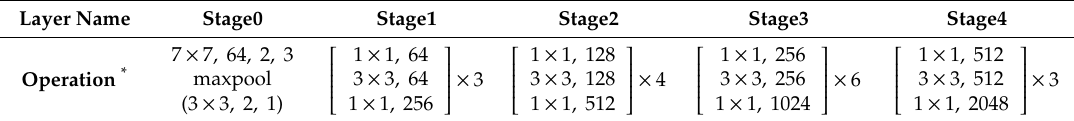
Table 2. The architecture of the backbone part in the network: ResNet50 [37].